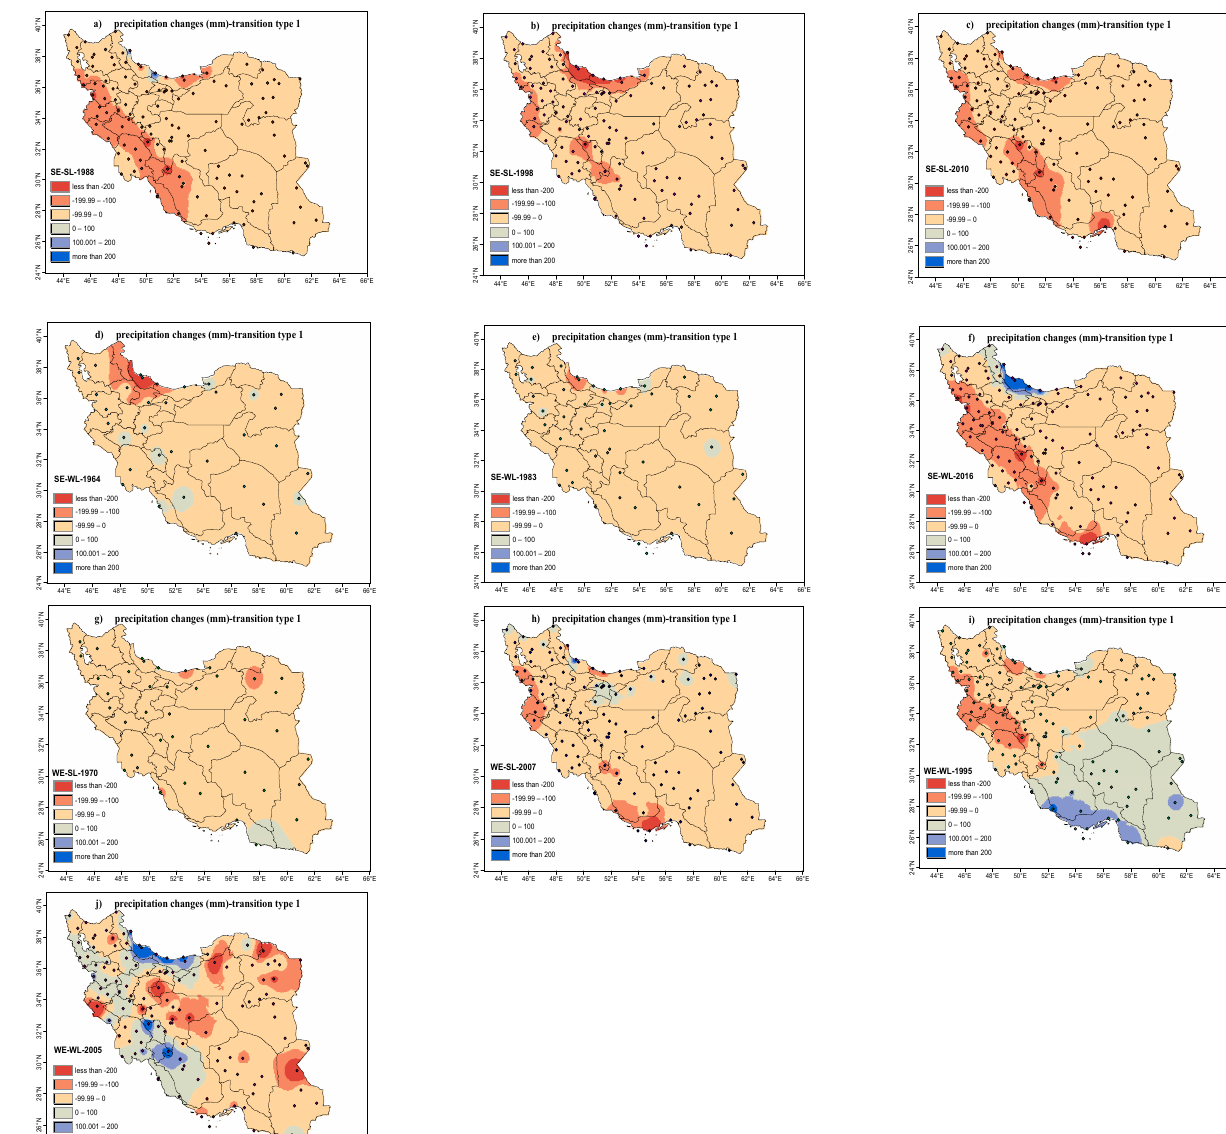
Figure 1. Precipitation anomalies (yearly minus climatology) during all years of ENSO phase transition type 1.